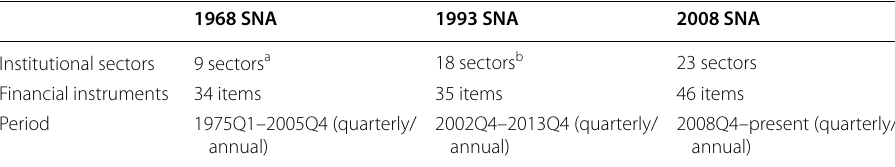
a Five sectors on the BOK Web site, Economic Statistics System